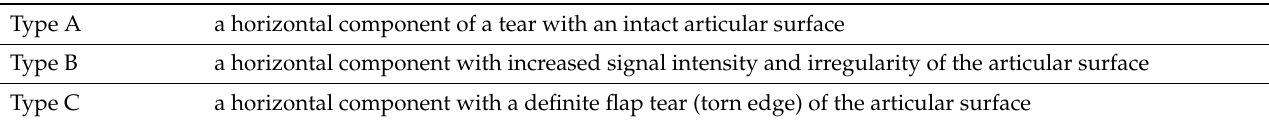
Table 1. Delaminated tear of partial-thickness tear by Lee et al. [13].